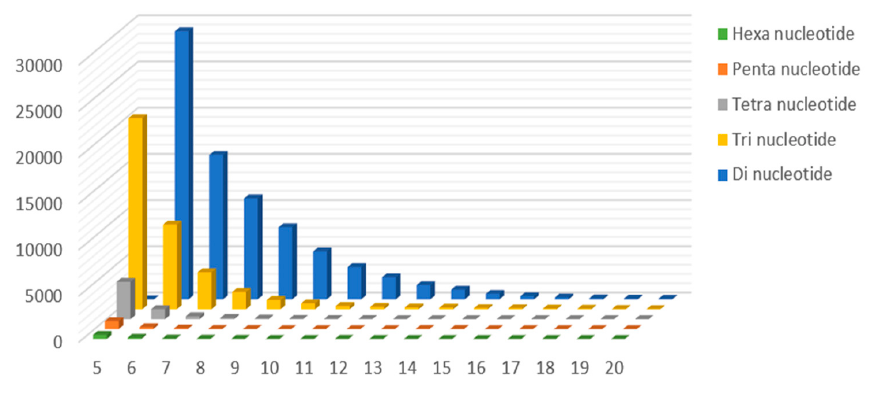
Figure 4. The distribution and frequency of SSR motif repeat numbers. ( x -axis, SSR repeat numbers; y -axis, frequency of this SSR type; blue bars, di-nucleotide repeat motifs; yellow bars, tri-nucleotide repeat motif; gray bars, tetra-nucleotide repeat motifs; orange bars, penta-nucleotide repeat motifs; and green bars, hexa-nucleotide repeat motifs.)